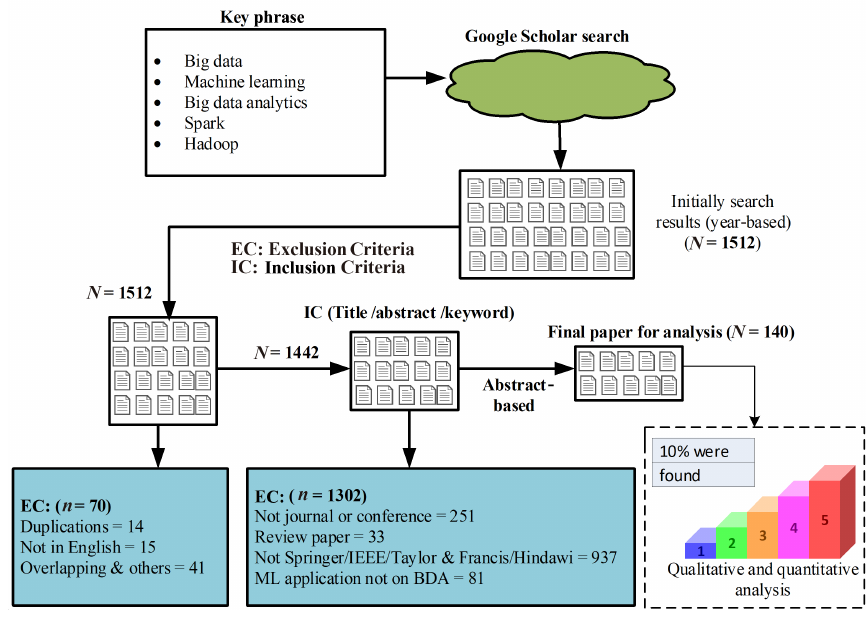
Fig. 4 Systematic literature review process.